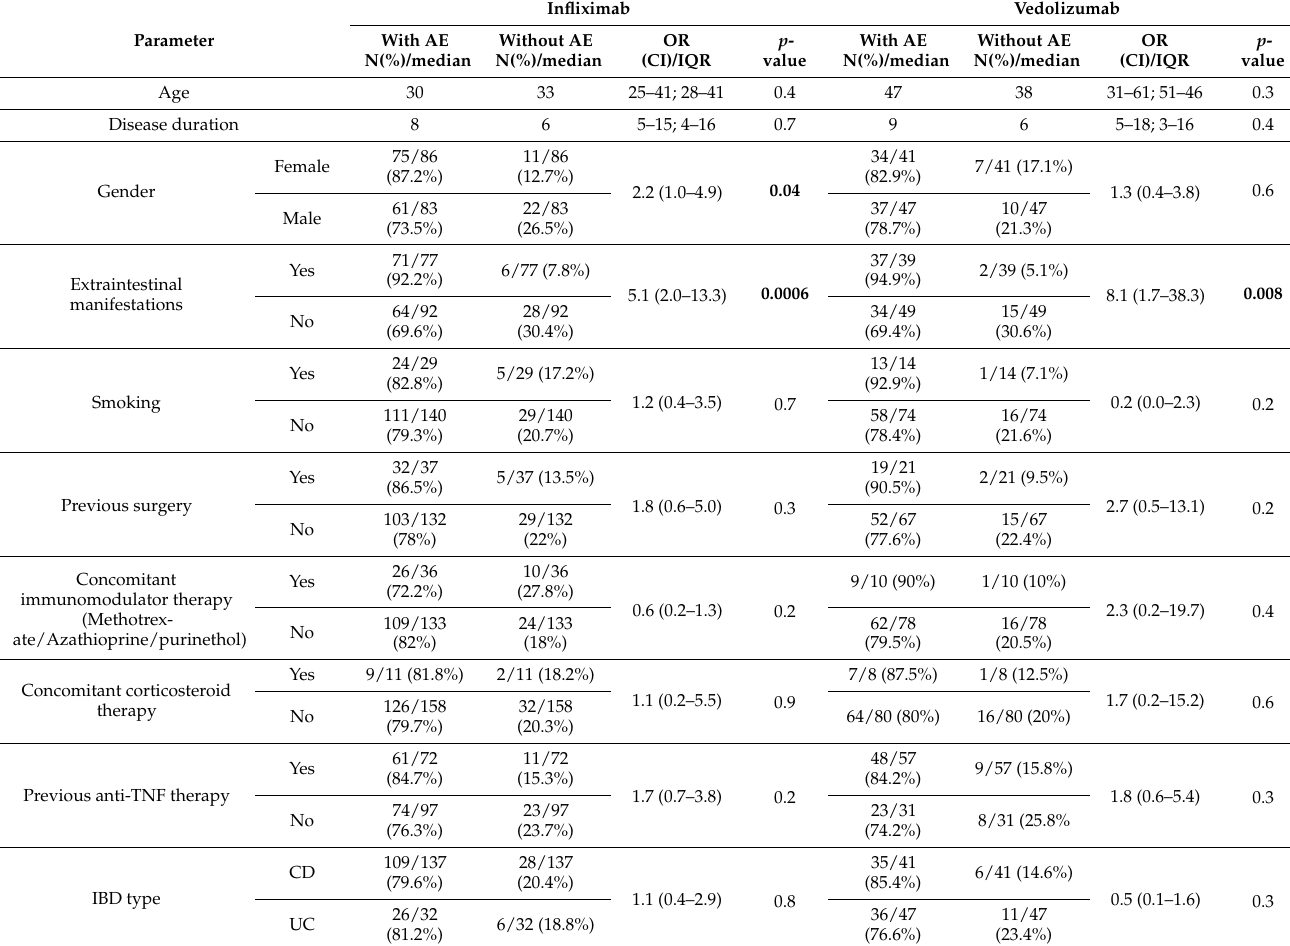
Table 2. Association of baseline parameters with adverse